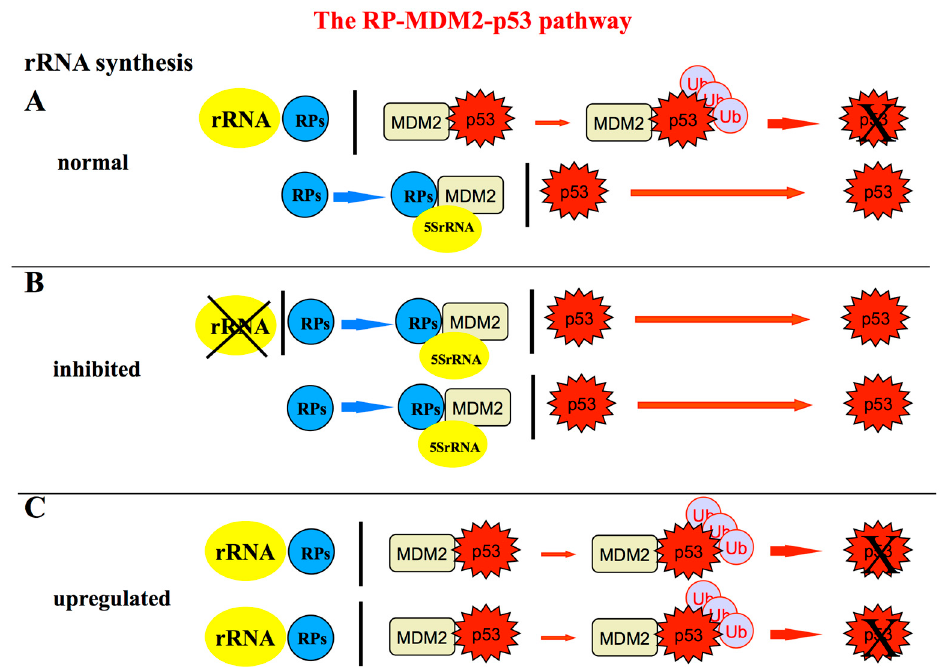
Figure 5. Schematic representation of the RPs-MDM2-p53 pathway showing the relationship between ribosome biogenesis rate and the level of p53 stabilization; ( A ) in normal conditions, the p53 level within the cell is maintained low because p53 is a short-lived protein that is rapidly degraded by murine double minute 2 (MDM2) and HDM2 in humans. In fact, MDM2 acts as an E3 ubiquitin ligase facilitating p53 proteasomal degradation [75–77]. Only a limited amount of MDM2 is inhibited by RPs not used for ribosome biogenesis. Among the RPs binding to MDM2, RPL11-uL5 and RPL5-uL18 play a major role in MDM2 inactivation [41–43,49] by forming a complex with 5S